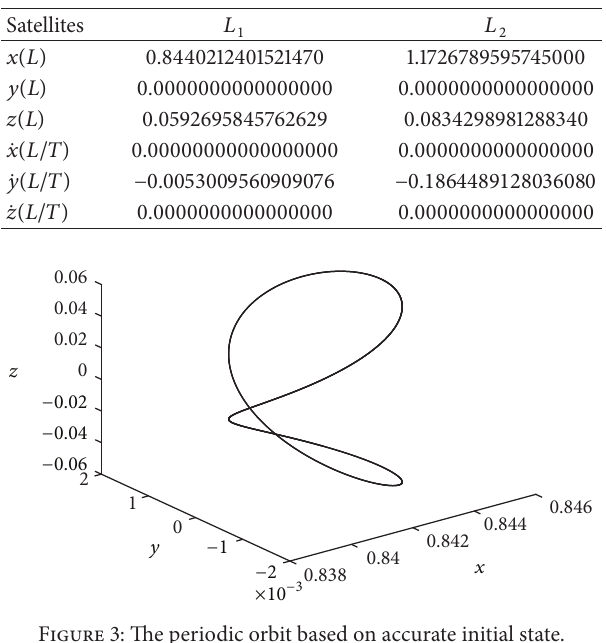
Figure 3: The periodic orbit based on accurate initial state.